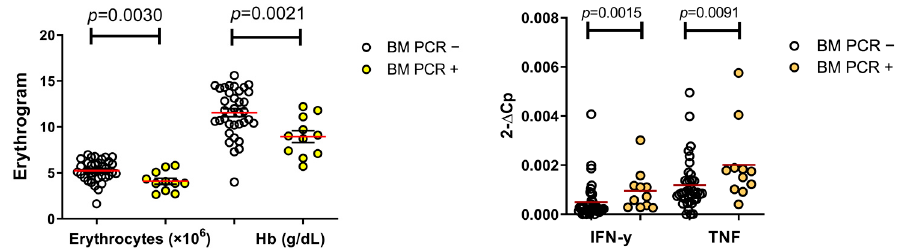
Figure 5. Erythrocytes, hemoglobin and gene expression levels of IFN- γ and TNF in the bone mar- row of infected dogs. Hb = hemoglobin; BM = bone marrow. (Mann–Whitney and Student’s t